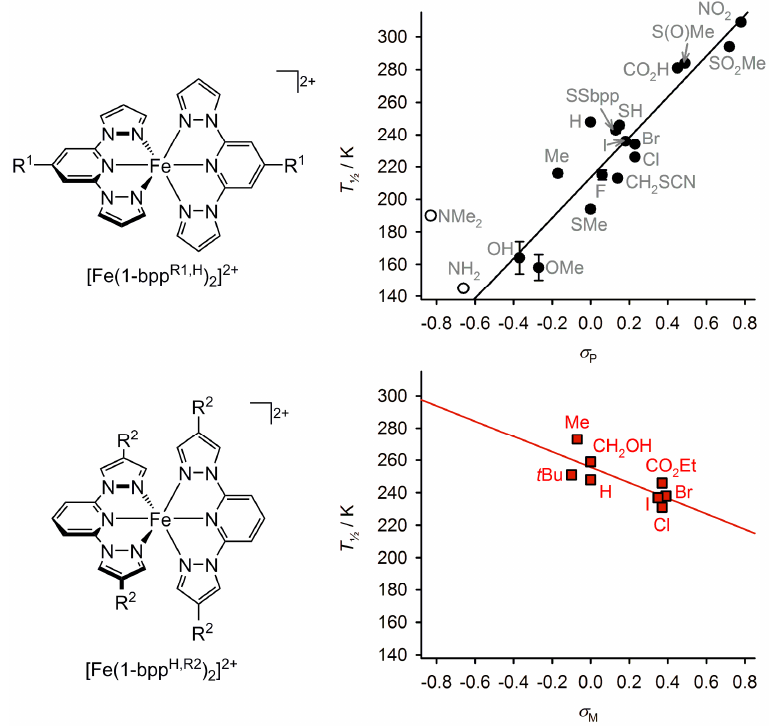
Figure 6. Linear SCO free energy relationships for [Fe(1-bpp) 2 ] 2+ bearing pyridyl R 1 (black circles) and pyrazolyl R 2 ( red squares ) substituents. Data were measured in (CD 3 ) 2 CO or CD 3 NO 2 solution [97]. The data points for R 1 = NH 2 and NMe 2 ( white circles ) represent upper limits for those T ½ values, since those complexes remained fully high-spin within the liquid range of the solvent used.